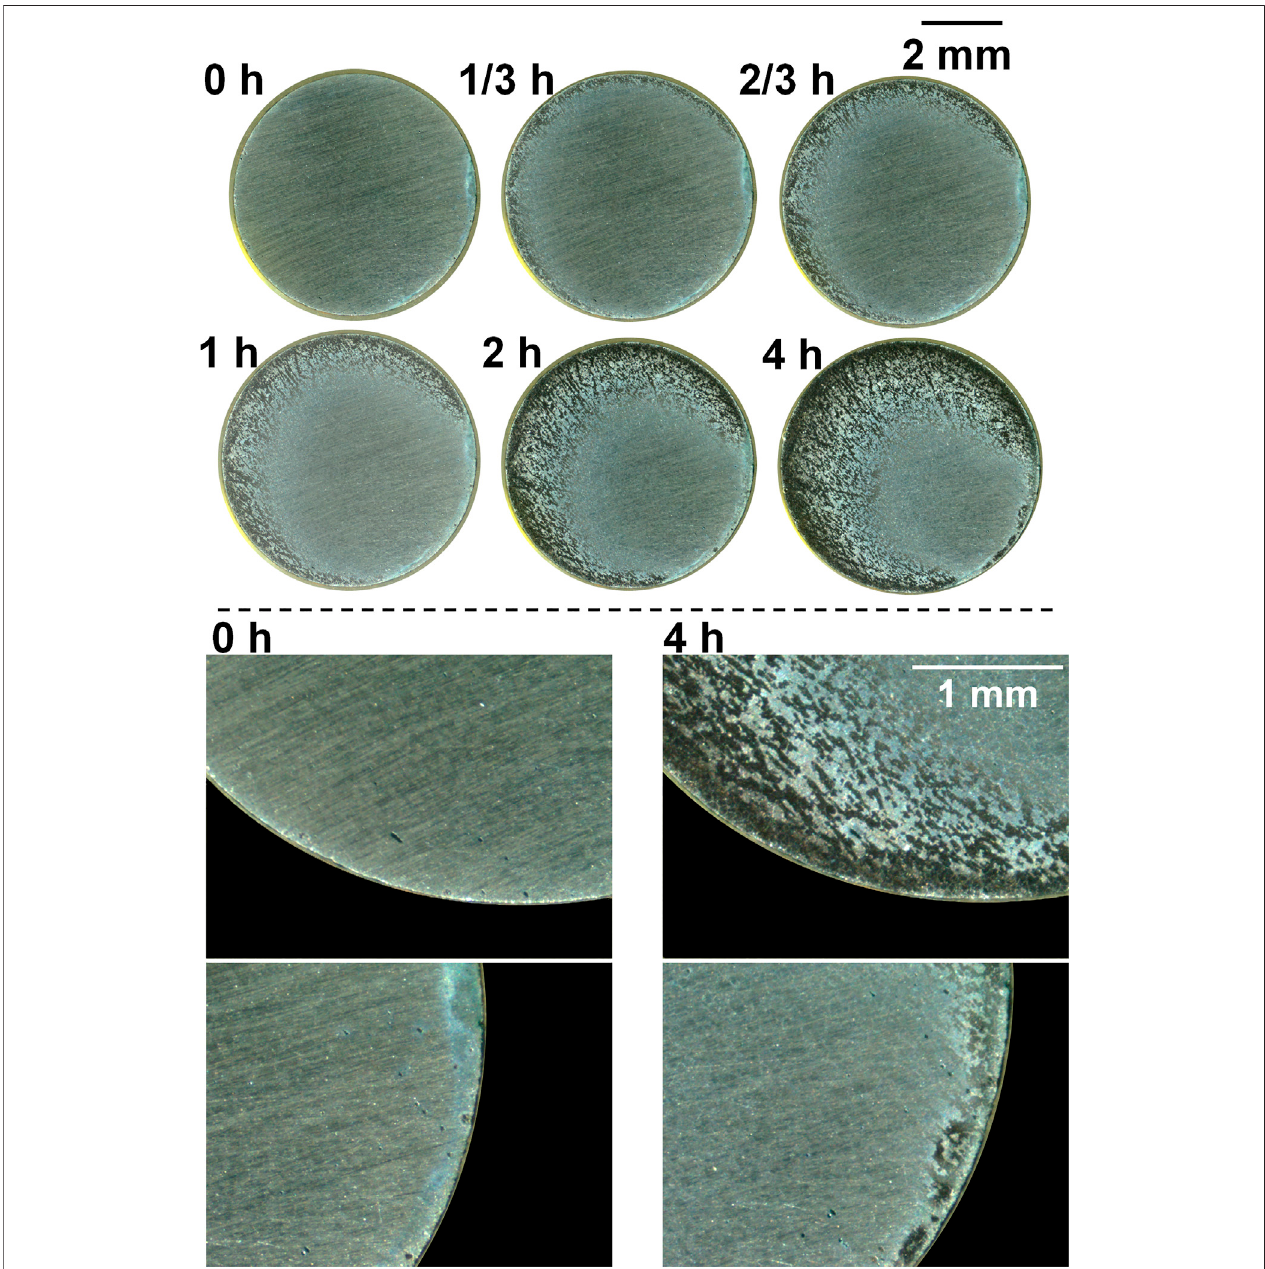
FIGURE 8 | Macrographs of the surface of the sample after heat treatment with the cooling rate 10 ° C/s presenting crevice corrosion development at 0.15 V vs. OCP in 0.1 M NaCl, taken by the self-designed device (lower part shows bottom left and right of the surface).